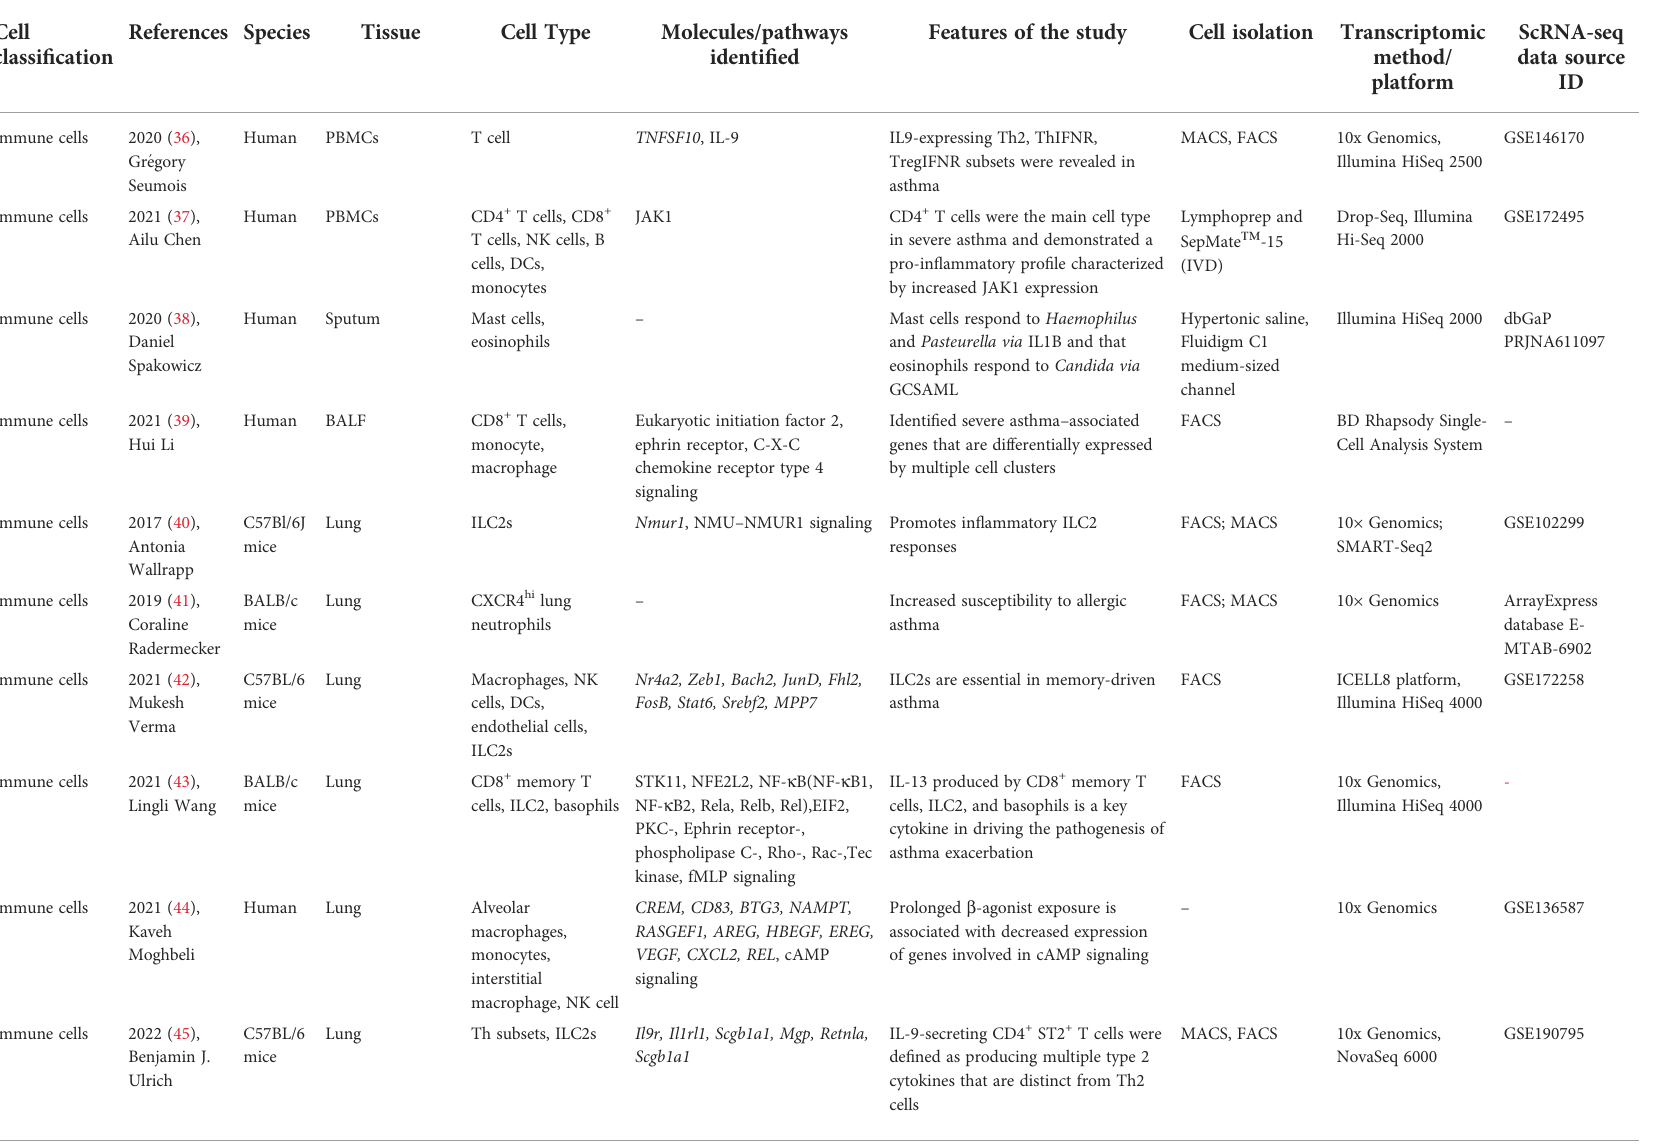
TABLE 2 Summary of scRNA-seq in